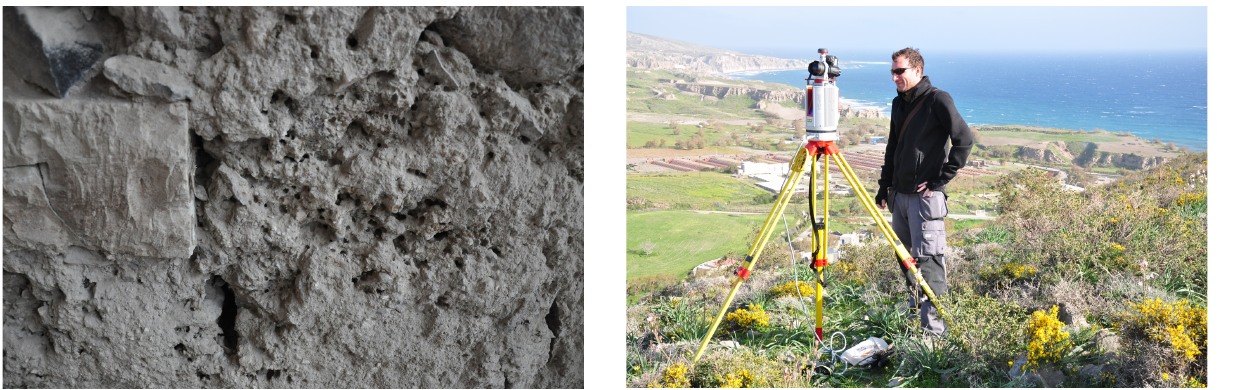
Figure 4: Outdoor laser scanning with the Riegl VZ-400 scanner on Mesa Vouno ridge west of the Akrotiri excavation site, whose shelter is visible in the background.